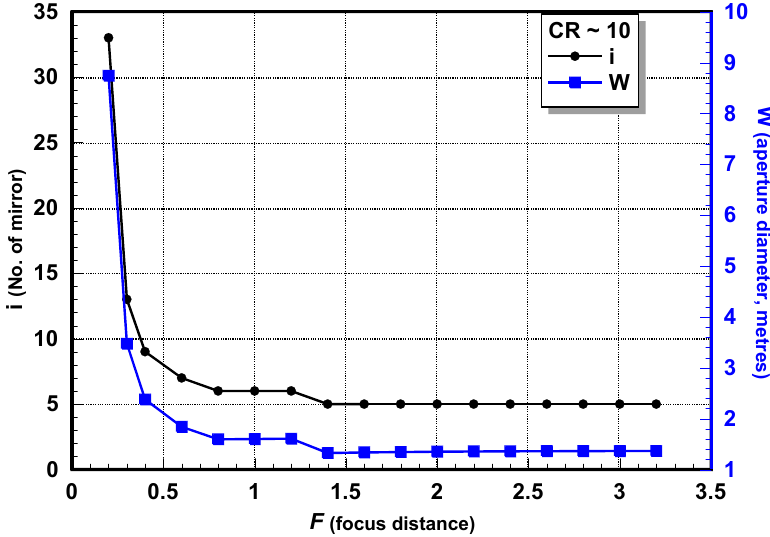
Figure 10. Variation number of mirrors and concentrator width with focus distance.